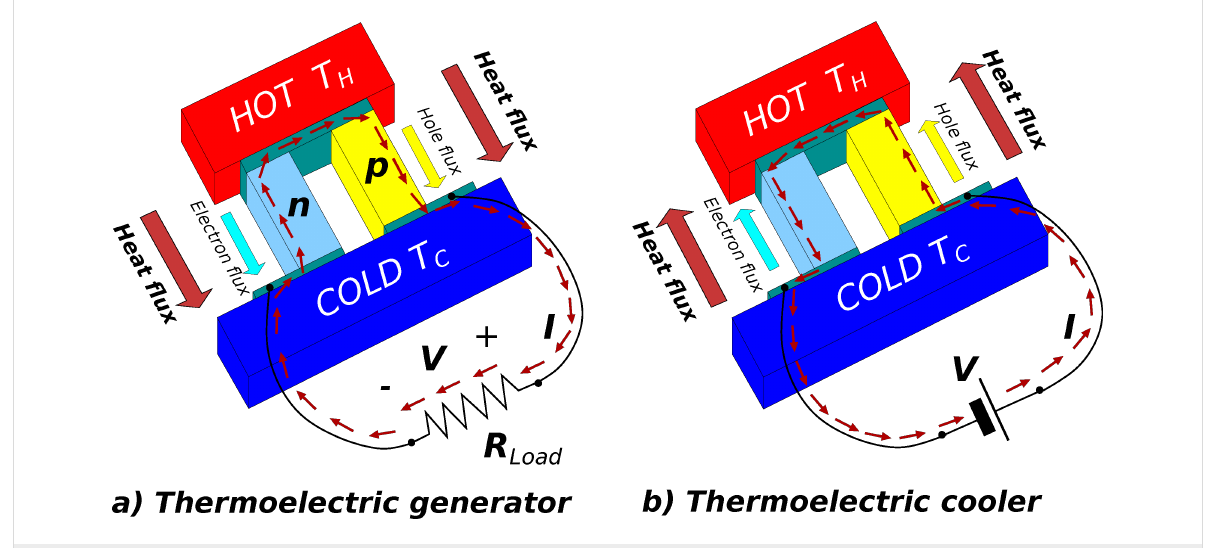
Figure 2: a) Sketch of a thermoelectric generator: two pieces of semiconducting materials with different (opposite) Seebeck coefficient can exploit a temperature gradient to deliver electrical power to an external load R Load , indicated with R L in the text. b) Sketch of a thermoelectric cooler: a battery imposes a current through the legs, so that the flux of the charge carriers brings heat from the cold extremity to the hot extremity of each leg.